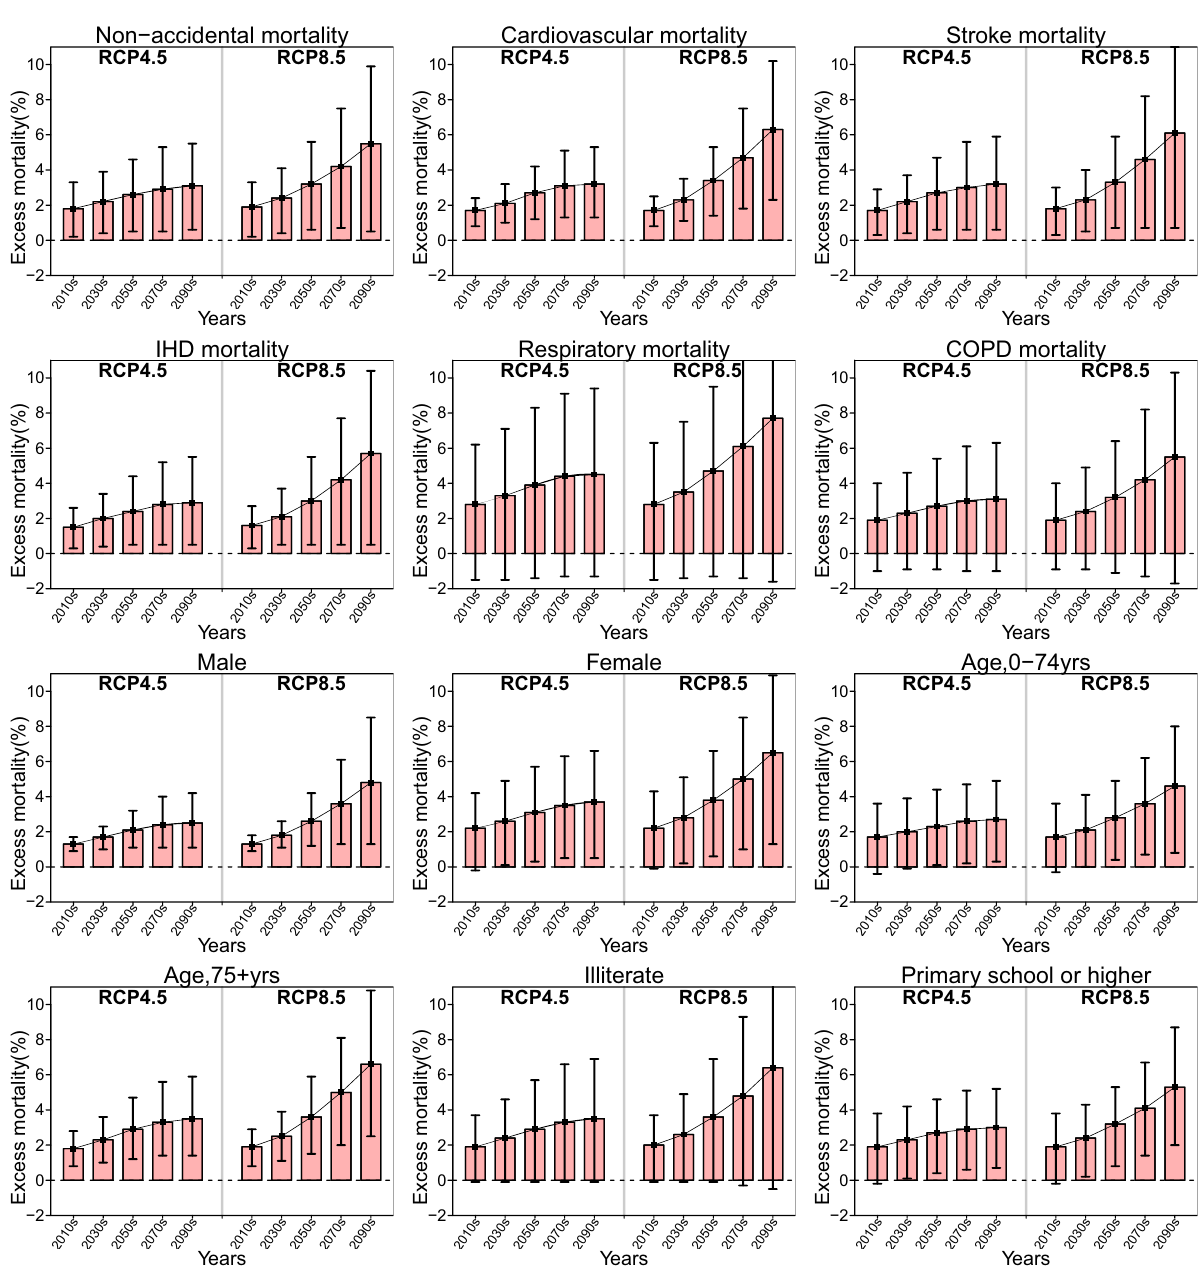
Fig. 3 The trends in heat-related excess mortality by period, cause, and individual characteristics in China assuming no adaptation or population changes. The excess mortality (red bar) was represented as the fraction of deaths (%) attributable to high temperature, with 95% empirical con fi dence intervals (the vertical black line). A distributed lag nonlinear model was used to estimate the district/county-speci fi c temperature-mortality association with 14 days of lag adjusted for time trends and day of the week, which were pooled in a multivariate meta-analysis. Then, estimates of the attributable fraction of deaths due to high temperature, de fi ned as temperatures above the optimum temperature, were calculated at the national level. Monte Carlo simulations generating 1000 samples were computed to produce empirical con fi dence intervals. The analyses were separately repeated by cause of death and individual characteristics. Source data are provided as Supplementary Data